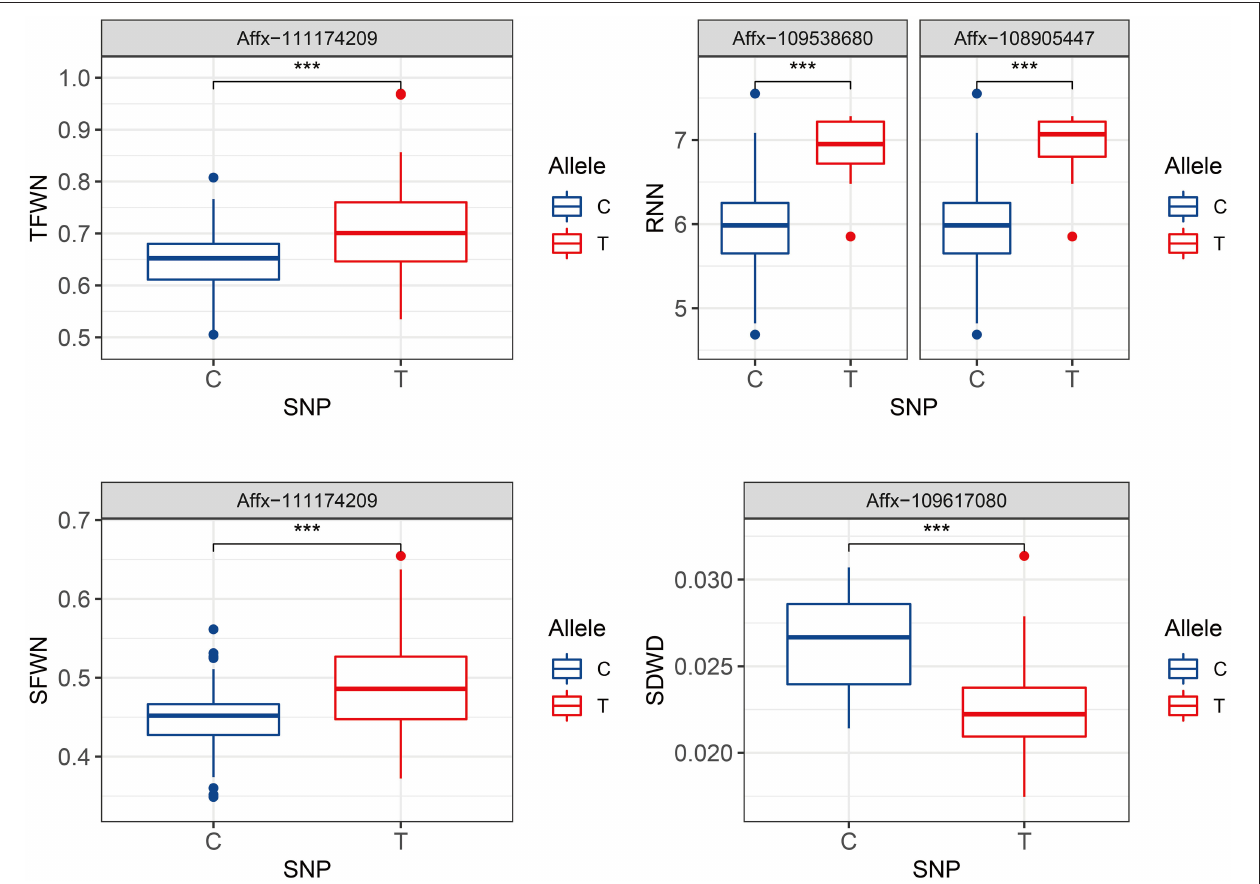
FIGURE 3 | Comparison of the allele effects of four environmentally stable SNPs on chromosomes 2D, 4D, and 6D. Trait abbreviations: TFWN, total fresh weight in controlled environment; SFWN, shoot fresh weight in controlled environment; RNN, root number in controlled environment; SDWD, shoot dry weight in drought environment. *** p <